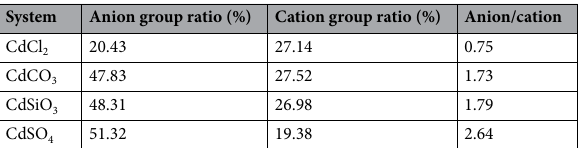
Table 3. Proportion of groups in CdCl 2 , CdCO 3 , CdSiO 3 and CdSO 4 .